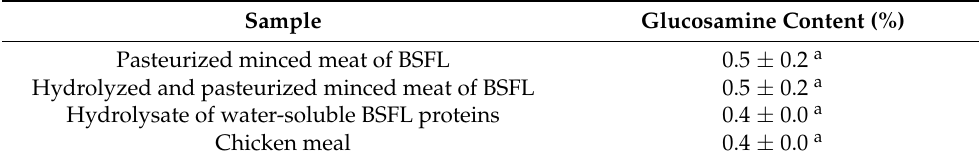
Table 1. Glucosamine content of BSFL protein derivatives and chicken meal. Sample Pasteurized minced meat of